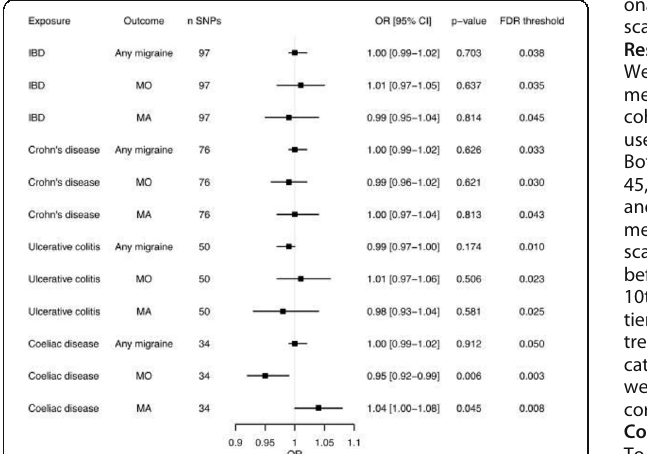
Fig. 1 (abstract P127). Effects of genetic liability to gastrointestinal conditions on migraine . Forest plot of two-sample MR effect estimates for IBD and coeliac disease on migraine based on the inverse-variance weighted method